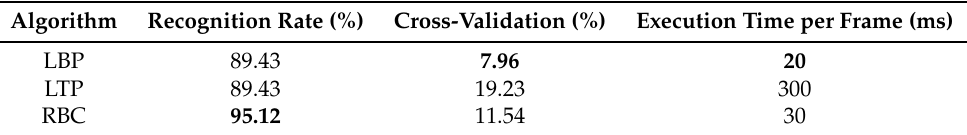
Table 1. A summary of texture descriptors’ results.